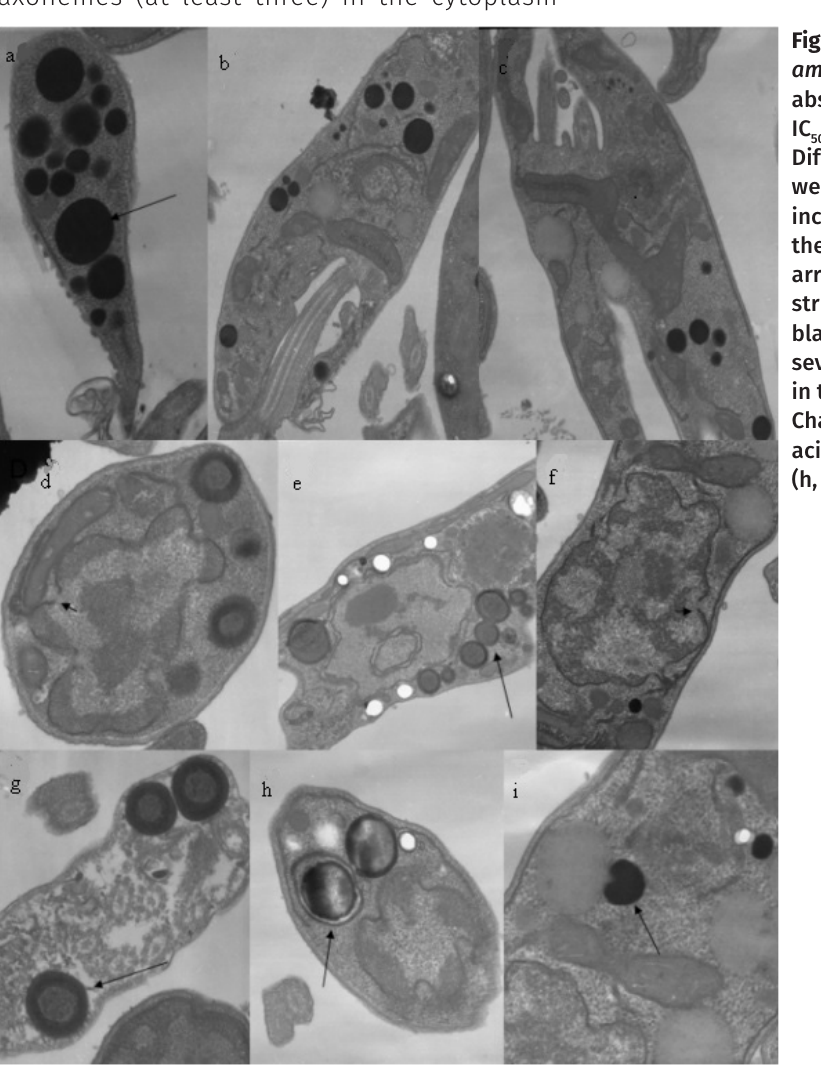
Figure 1. Analysis by TEM of L. amazonensis promastigotes in absence (a-c) or presence (d-i) of IC D. (S.) latex aqueous extract. 50 Different degrees of damage were observed in treated cells, including the discontinuity of the nuclear membrane (d and f arrowhead), formation of concentric structures with membranes (e, black arrow), and the presence of several axonemes (at least three) in the cytoplasm (g, black arrow). Changes in the electron density of acidocalcisomes were also observed (h, i, black